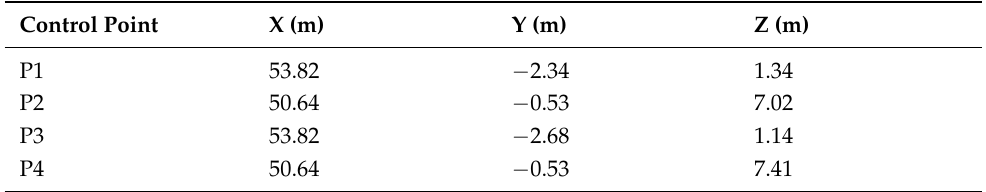
Table 2. Control points locations measured from baseline used to probe flow velocity on the hull of a Type 209/1300